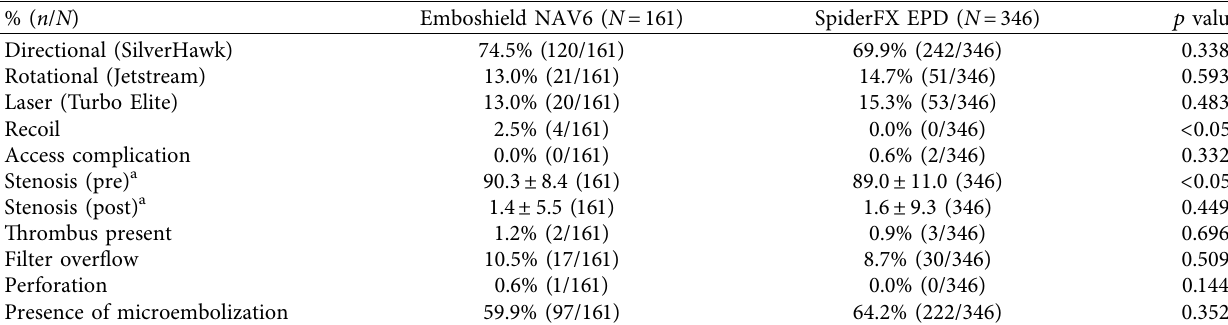
Table 3: Procedural results.